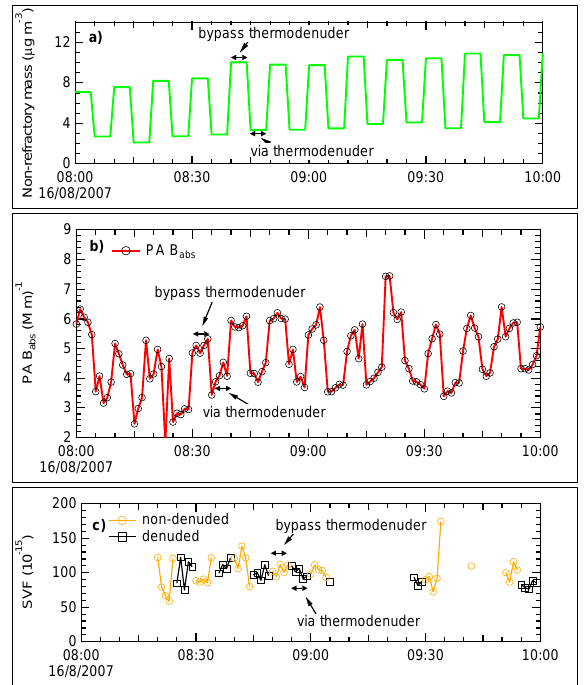
Figure 1: Variations of (a) the non-refractory mass measured by the AMS during the thermodenuder experiment for a 2-hour period on August 16, 2007, (b) the particle light absorption ( B abs ) measured by the photoacoustic spectrometer during the same period, and (c) the soot volume fraction (SVF) measured by the laser-induced incandescence instrument during the same period. For clarity, the SVF measured during the denuded and non-denuded periods are presented by different markers.